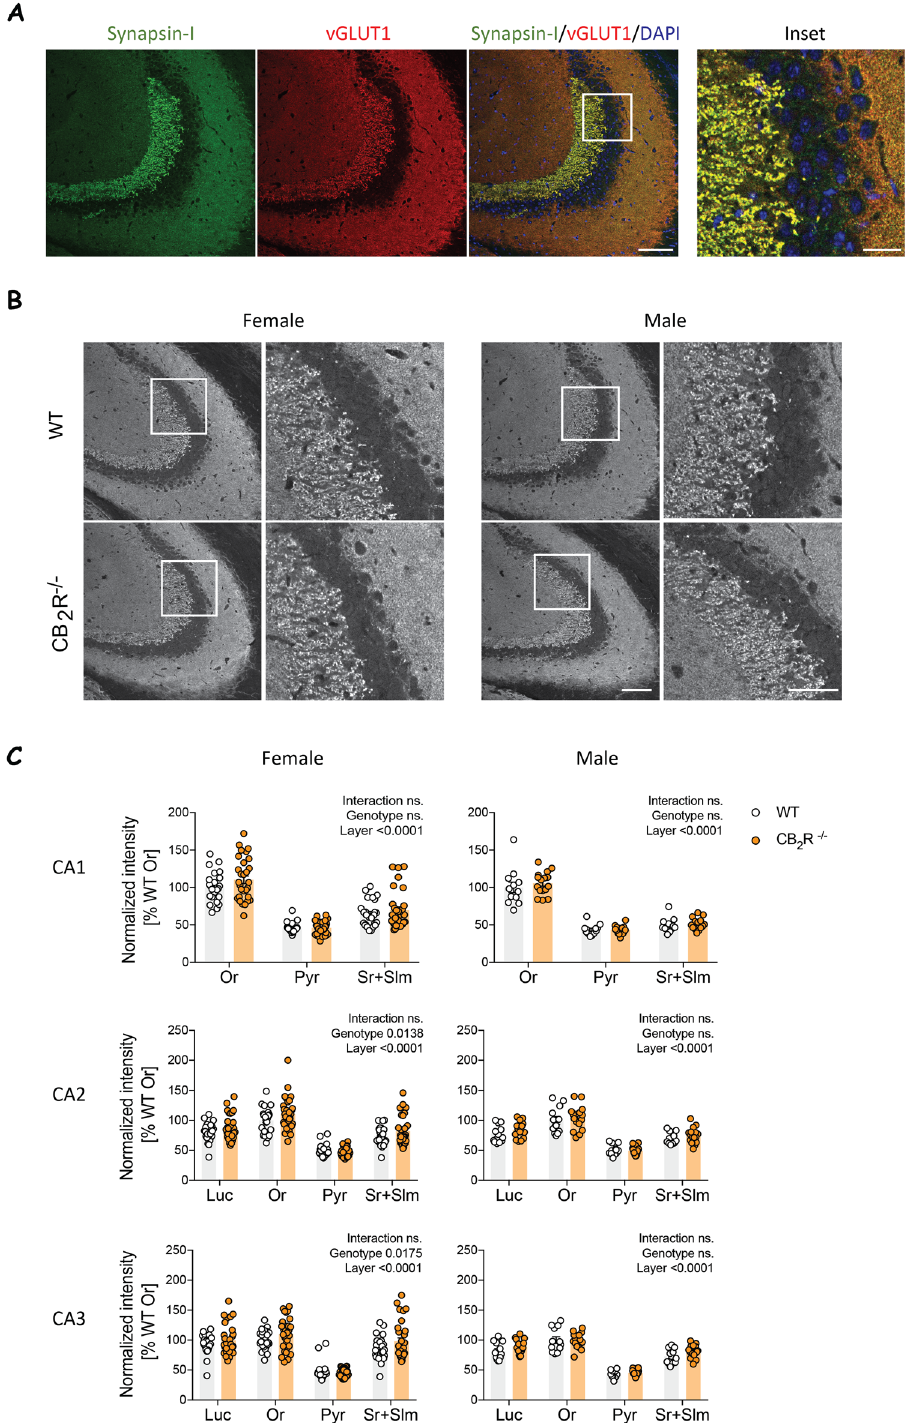
Figure 3. vGLUT1 levels are slightly increased in female CB 2 R −/− mice. ( A ) Example images show synapsin-I (green), vGLUT1 (red) and DAPI (blue). Scale bar: 100 µm, 25 µm (inset). ( B ) Example images of vGLUT1 immunoreactivity in male and female from WT and CB 2 R −/− mice. The white box within the left panel indicates the section that is displayed in higher magnification on the right. Scale bar: 100 µm, 50 µm (inset). ( C ) Quantification of vGLUT1 mean grey value within each hippocampal layer normalized to the result from stratum oriens (Or). Or stratum oriens, Luc stratum lucidum, Pyr stratum pyramidale, Sr + Slm stratum radiatum and stratum lacunosum-moleculare. White circle—WT; orange circle—CB 2 R −/− mice. Each datapoint represents one image. Left panel—female mice (WT: n = 30 images from N = 9 mice; CB 2 R −/− : n = 31 images from N = 9 mice); right panel—male mice (WT: n = 12 images from N = 3 mice; CB 2 R −/− : n = 16 images from N = 4 mice). Top panel—CA1 region; middle panel—CA2 region; bottom panel—CA3 region. Data is displayed as mean value ± SEM. Data was analyzed by two-way ANOVA followed by Sidak’s multiple comparison test. The exact p-values are indicated on the graph and reported in Supplementary Table